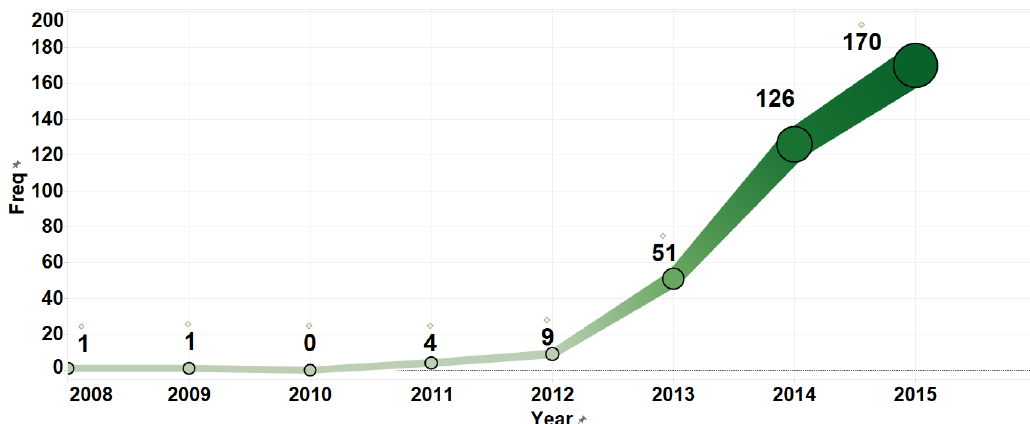
Figure 2. Frequency of the sampled articles by year (N =